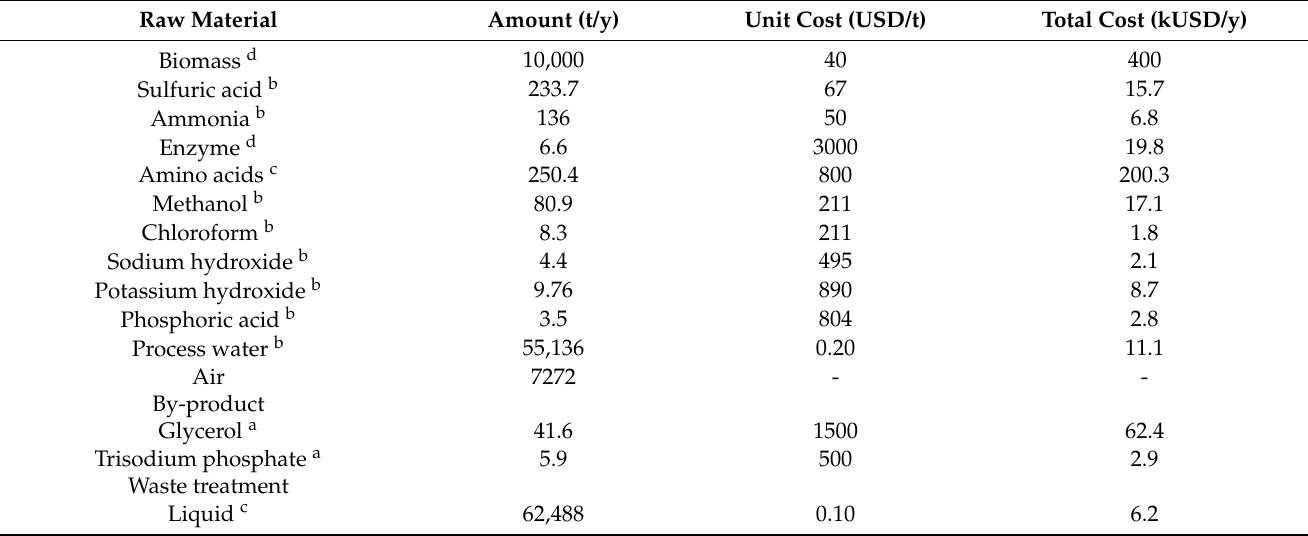
Table 11. Raw materials and byproduct prices.